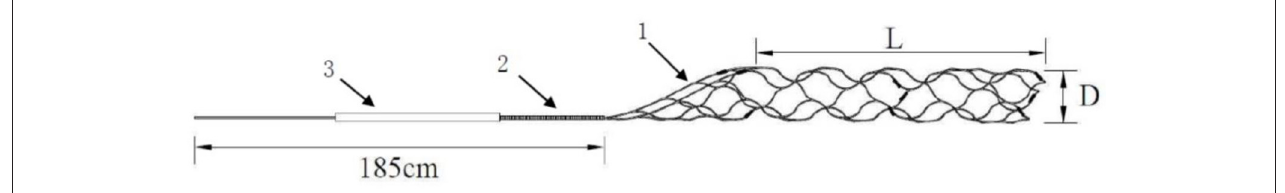
FIGURE 1 | Description of stent composition: there are different sizes of stent retriever, including TD 320, TD420, TD430, and TD440 requiring a compatible microcatheter of 0.021 inch and TD620 and TD630 requiring a compatible microcatheter of 0.027 inch. Stent retriever with double helix structure, partial large mesh and full development design (1), pushing wire 185 cm with a variable-diameter structure coiled with platinum alloy coil in the distal (2), introducer sheath (3), diameter of stent, 3 mm for TD 320, 4 mm for TD420, TD430, and TD440, 6 mm for TD620 and TD630 (D), and stent retriever effective length, 20 mm for TD 320, TD420, and TD620, 30 mm for TD430 and TD630, and 40 mm for TD440 (L). TABLE 1 | Visits and assessment schedule.